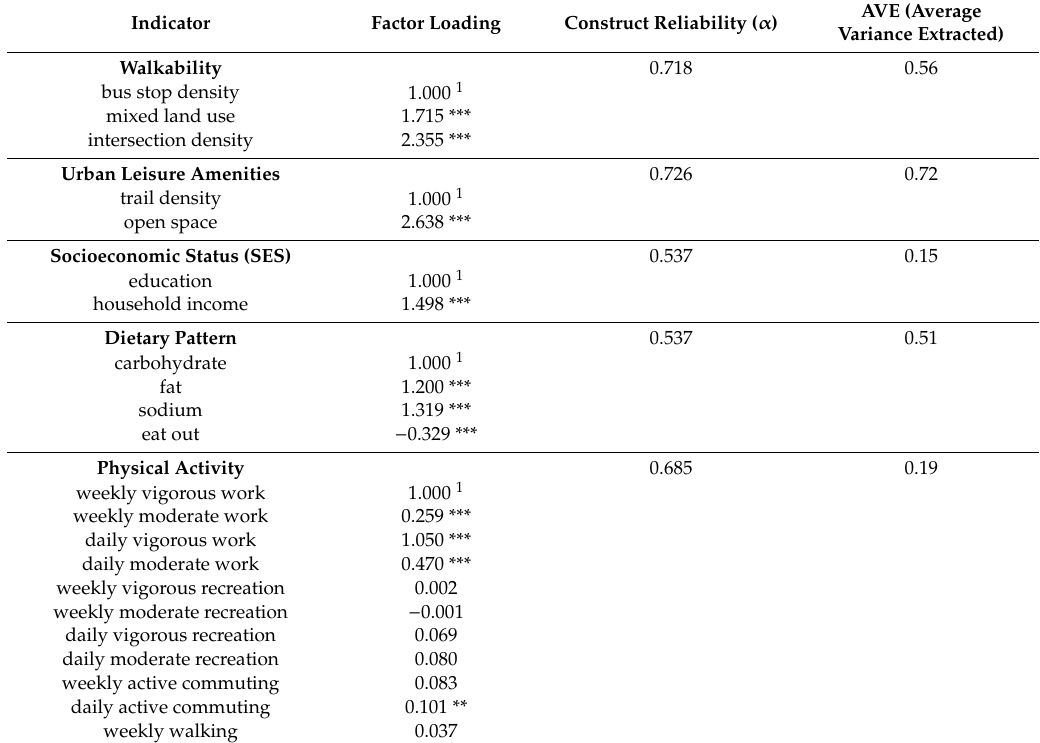
Table 1. Measurement information and reliability